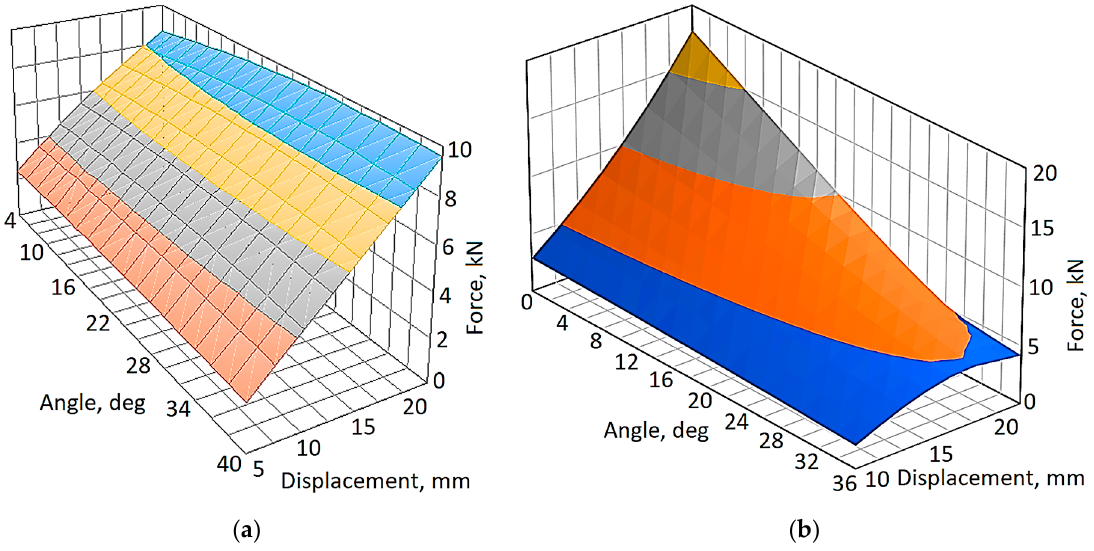
Figure 14. Surfaces Q K = Q ( S 1 , β 1 ) [kN] ( a ) and Q K = Q ( S 2 , β 2 ) [kN] ( b ) on the displacement S k [mm] and the angle β k [deg].